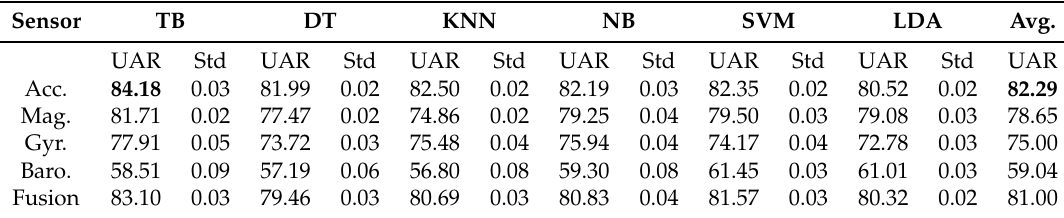
Table 4. Balanced Learning method results for the dominant hand: Unweighted Average Recall (UAR) in % along with the standard deviation (Std) of UAR for each fold (i.e., subject) of classification. The bold figures indicate the best results.